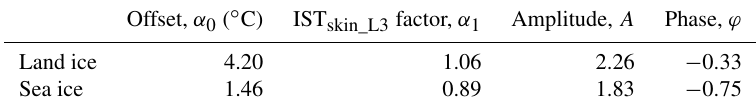
Table 4. Model regression coefficients for ÎST skin